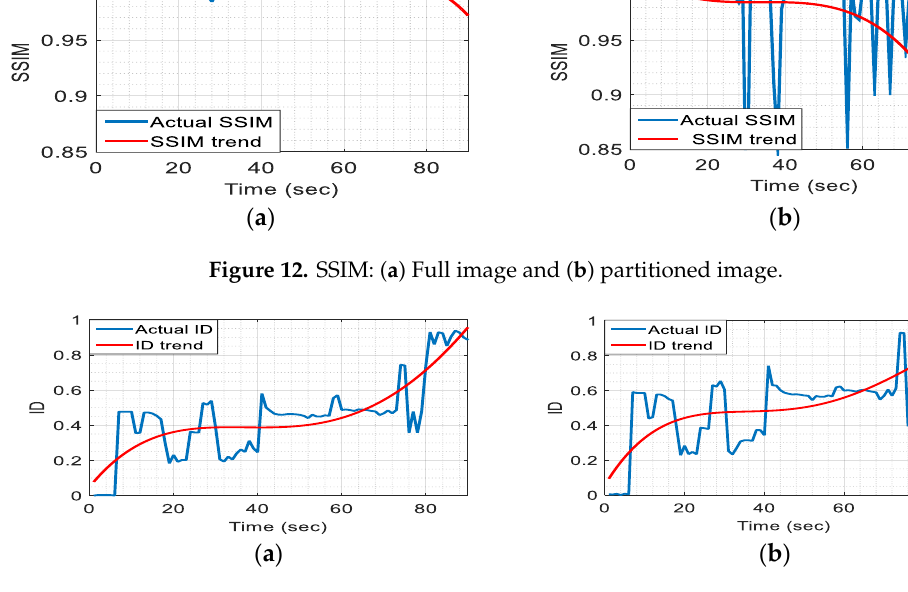
Figure 13. ID: ( a ) Full image and ( b ) partitioned image.